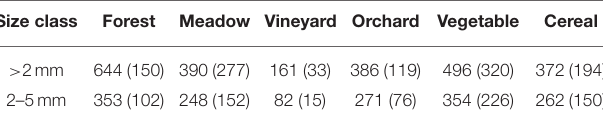
TABLE 3 | Mean numbers and standard deviations (in brackets) of nocturnal insects per